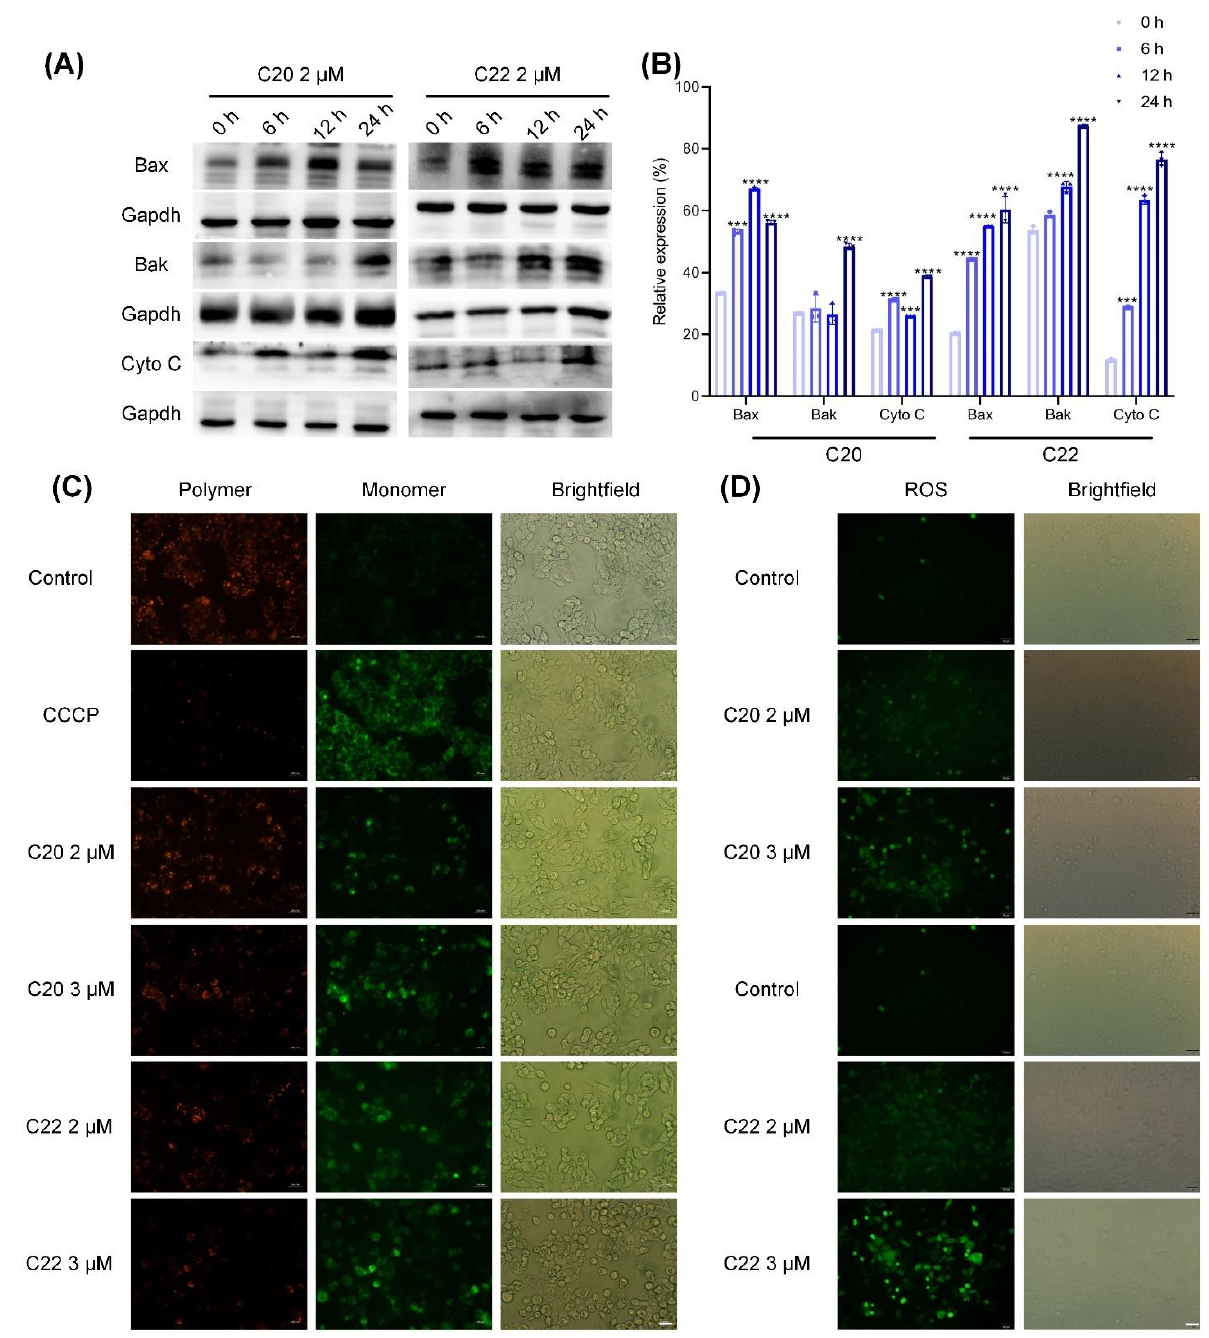
Figure 7. Treatment with C20/C22 induced ER stress and mitochondrial dysfunction increased the expression of proapoptotic proteins. HepG2 cells were treated with 2 and 3 μM of C20/C22 for 24 h. ( A , B ) WB analysis of the protein expression in HepG2 cells treated with 2 μM of C20/C22 for 0, 6, 12, and 24 h. The presented values correspond to the mean ± SD for three independent experiments. The p -value was analyzed by one-way ANOVA followed by Tukey’s test using GraphPad Prism version 8.00. *** p < 0.001, and **** p < 0.0001 vs. 0 h/control group. ( C ) JC-1 staining was performed to measure the MMP ( n = 3), CCCP, and carbonyl cyanide 3-chlorophenylhydrazone. ( D ) C20/C22- treated cells were stained with DCFH-DA, and the relative levels of intracellular ROS were determined via fluorescence microscopy ( n = 3). Scale bars, 50 µ